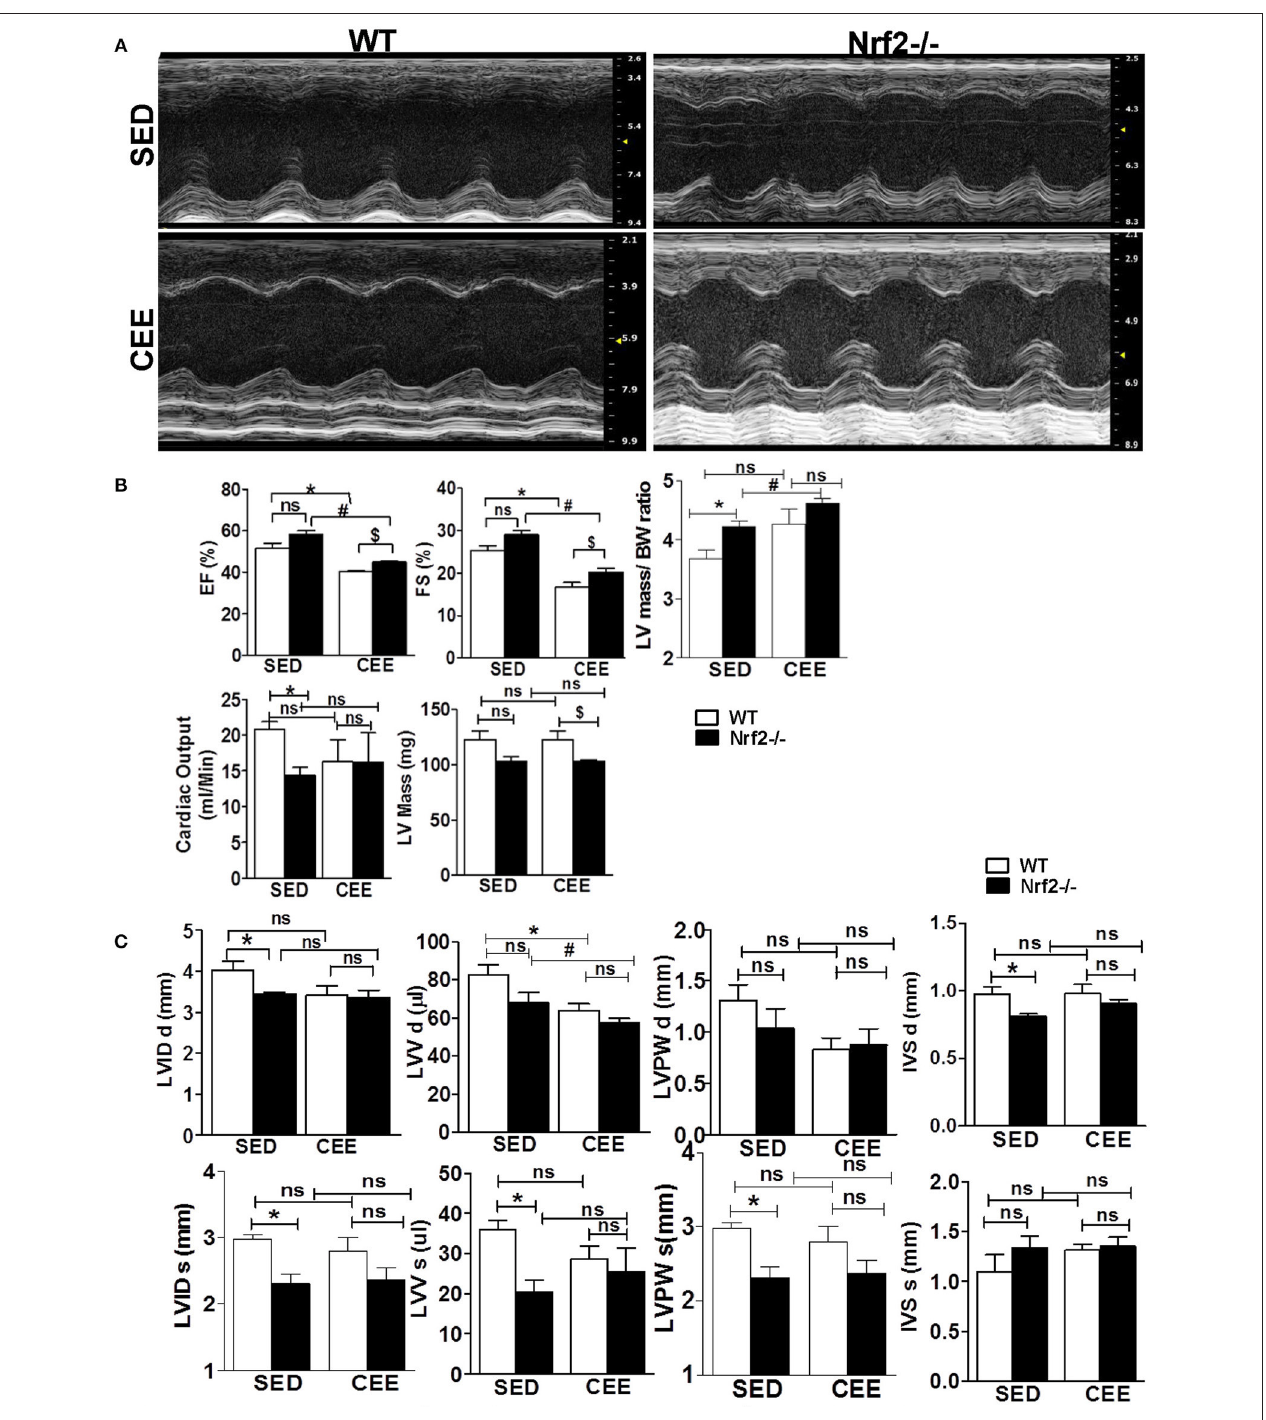
FIGURE 7 | Echocardiographic changes in Nrf2 − / − mice after chronic endurance exercise load: Echocardiography was performed using the Vevo2100 System (Visual-Sonics) with high-resolution (38 MHz). B-mode and M-Mode images were used to calculate the Echocardiography parameters. (A) Representative M-Mode echocardiography images of Nrf2 − / − mice and the wild-type littermate control under sedentary and endurance exercise stress. (B,C) Measurements of the ejection fraction (EF), fractional shortening (FS), left ventricular volume (LVV), LV weight, cardiac output, Interventricular septal diameter, Left ventricular posterior wall diameter and LV internal diameter (LVID d) are depicted in the histograms as mean ± SD , n = 4–6/group. Statistical analyses were performed using one way ANOVA followed by Tukey multiple comparison tests (* P < 0.05 vs. WT-SED, # P < 0.05 vs. Nrf2 − / − -SED, $ P < 0.05 vs. WT CEE).